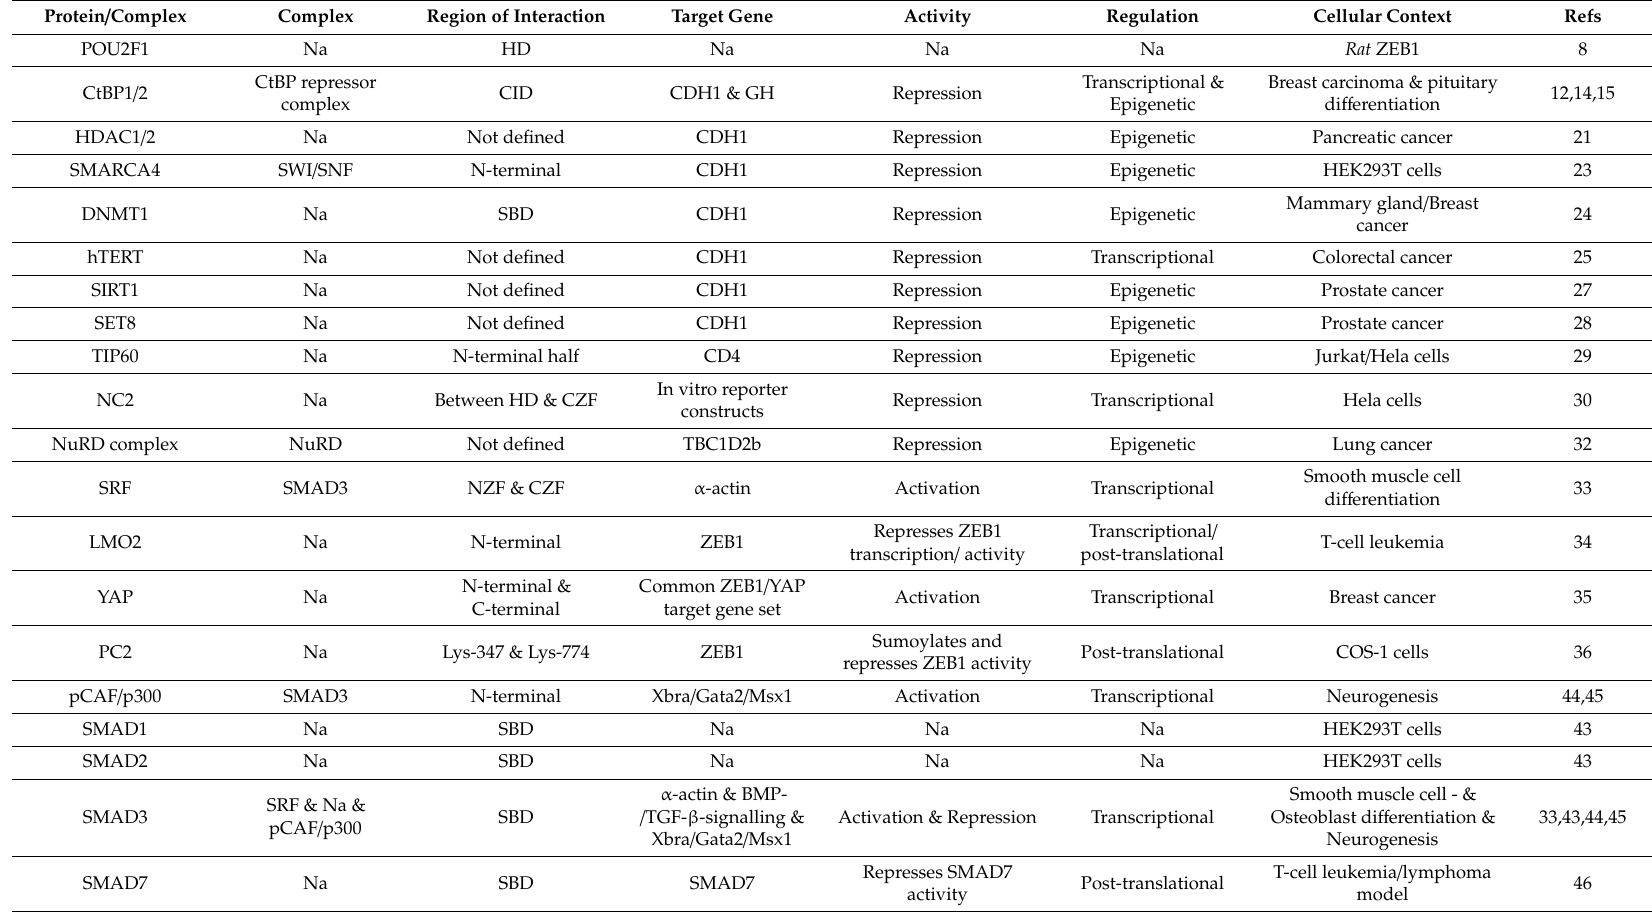
Table 1. Summary of known interaction partners of